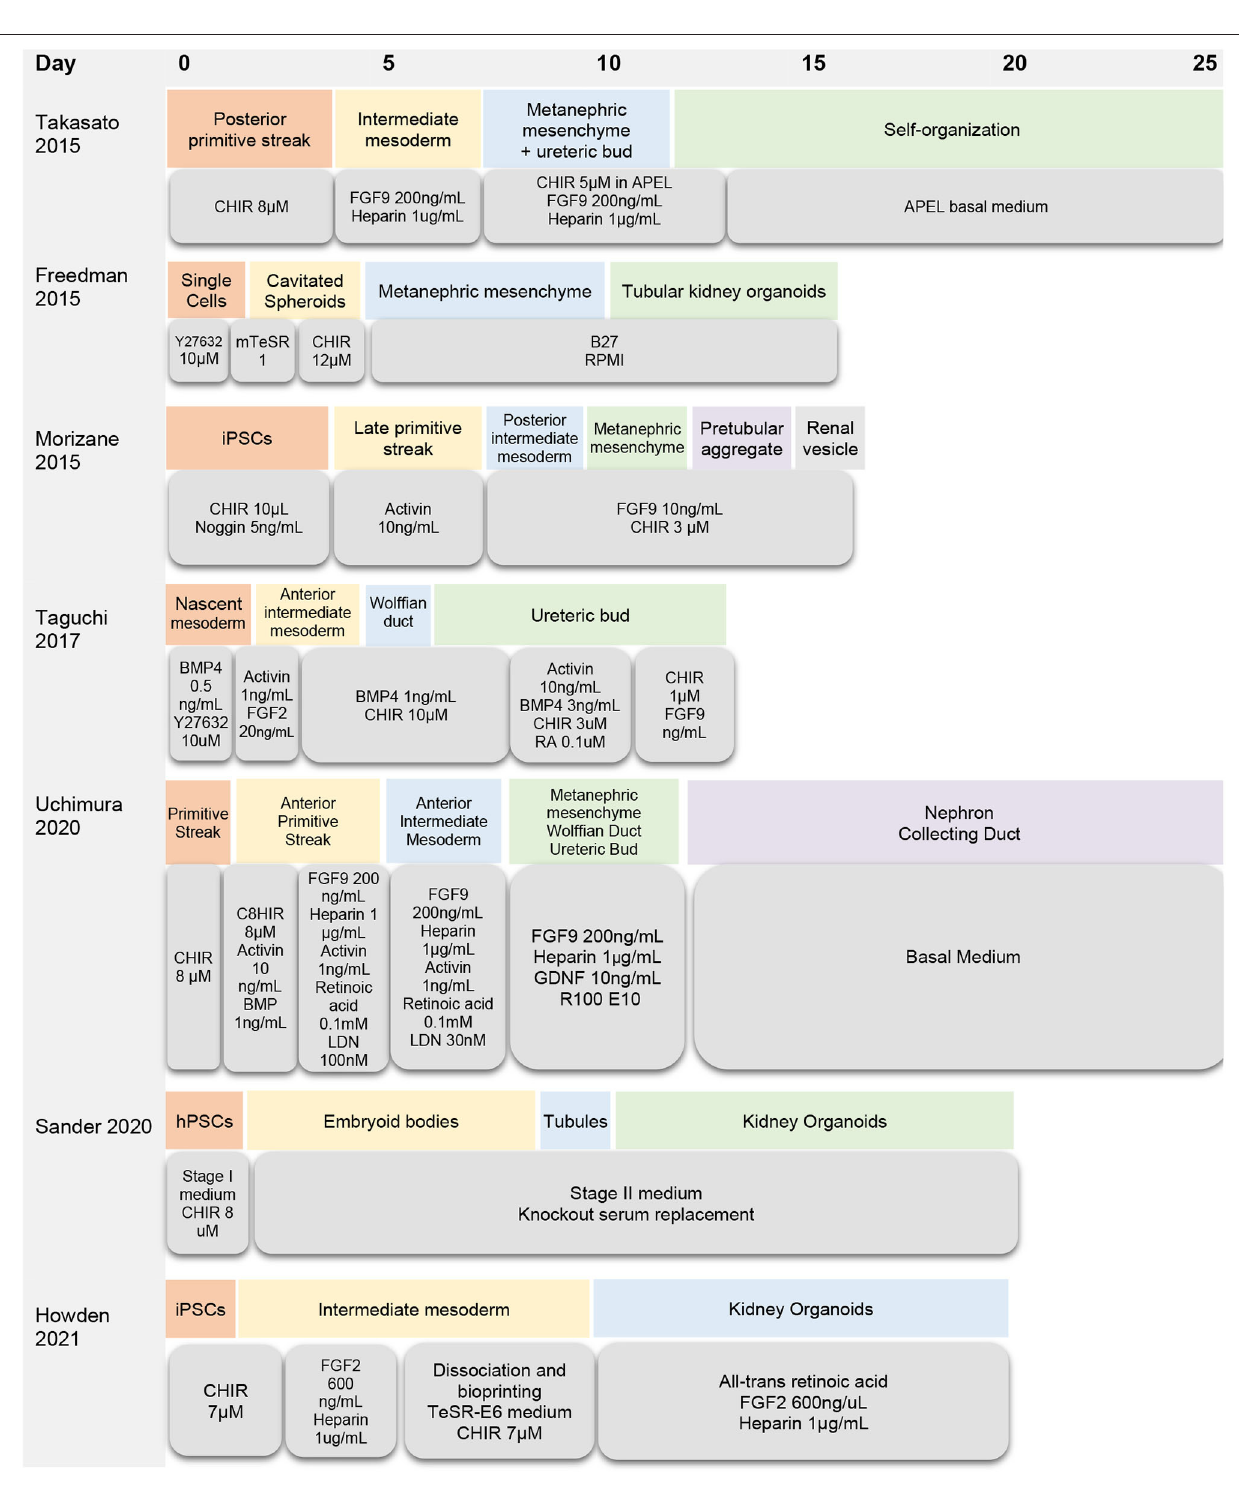
FIGURE 1 | Timeline of organoid differentiation